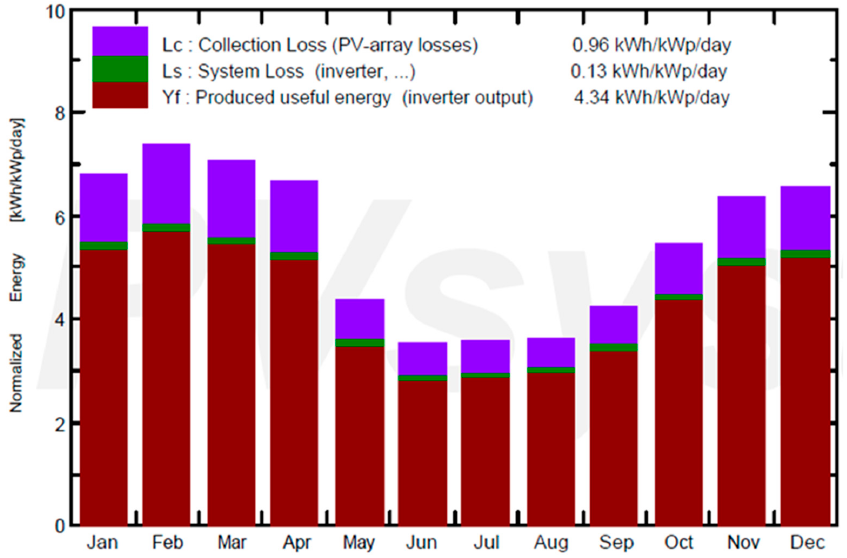
Figure 10. Normalized production.